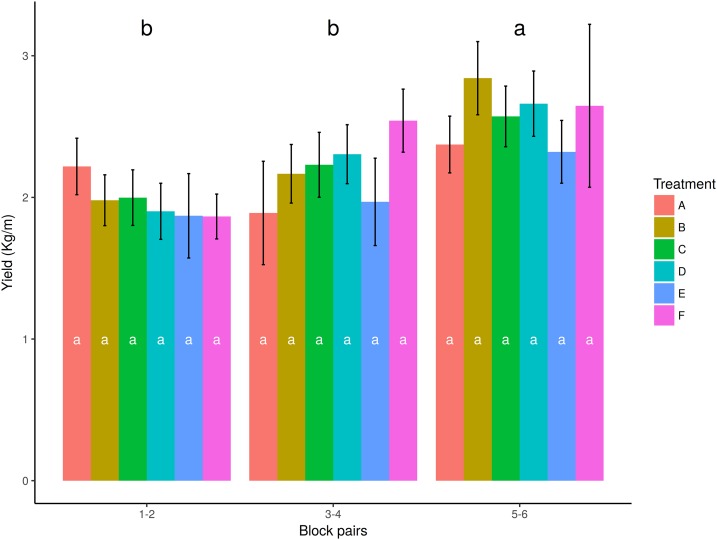
Mean yield values for treatments and block pairs.Colors represent treatments. The columns with the same letter represent values that are not significantly different at the 0.05 level of probability according to the HSD test. Error bars correspond to standard error. Treatments are noted as A: recommended Urtica dose; B: half the recommended dose; C: double the recommended dose; D: Urtica recommended dose in combination with Equisetum; E: conventional foliar manure; F: control. Winthin blocks, columns with the same letter do not differ significantly from each other at p ≤ 0.05 (HSD), among blocks, different letters indicate significant differences at p ≤ 0.05 (HSD).